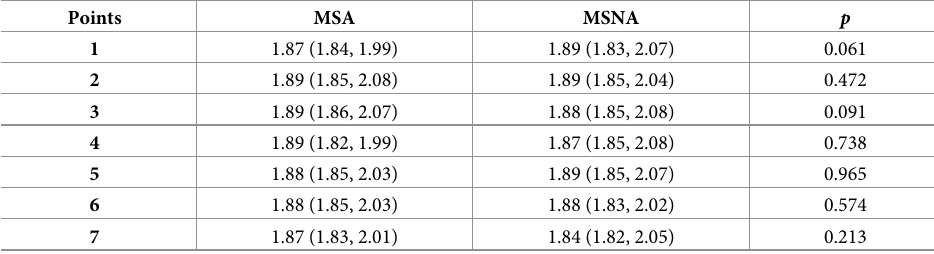
� Values presented in median (first quartile, third quartile). MSA: Affected upper limb by lymphedema. MSNA: Unaffected upper limb by